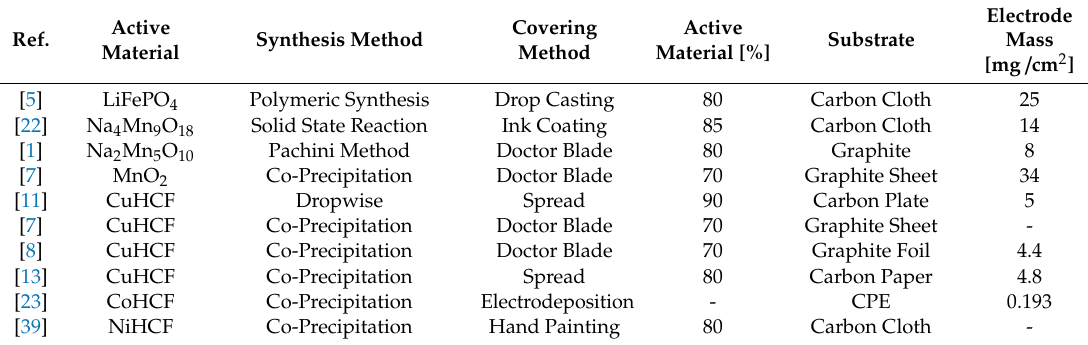
Table 4. Preparation of battery material and PBA for cathodes in MEBs.